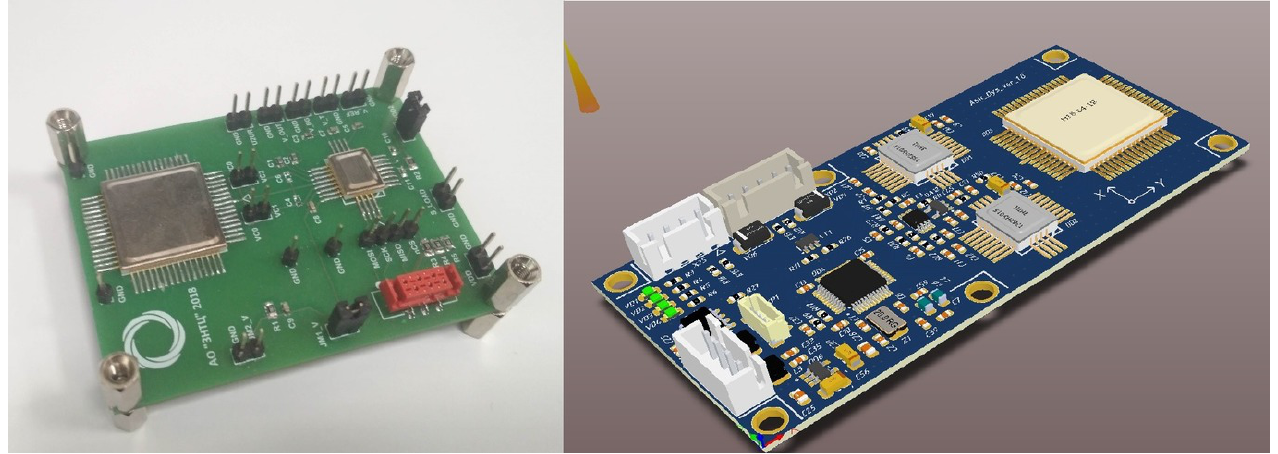
Figure 35. Debugging board based on one and two 5201TK015